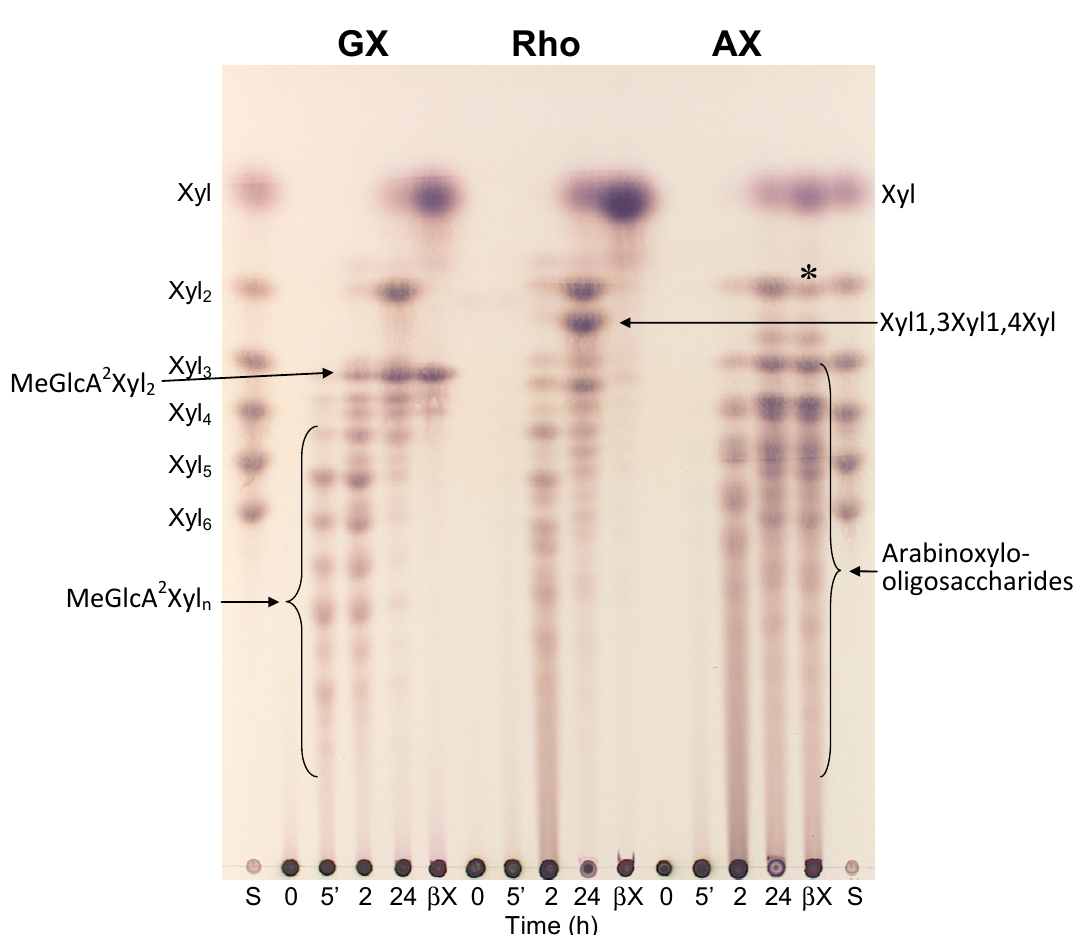
Figure 1. TLC analysis of the products generated by Tl Xyn30A xylanase from glucuronoxylan (GX), rhodymenan (Rho), and arabinoxylan (AX). After 24 h, Tl Xyn30A was heat-denatured and then the mixtures were treated with β -xylosidase for 24 h (lanes denoted by β X). Note a remarkable change in the products generated from GX and Rho upon the β -xylosidase treatment, in contrast to a resistance of the oligosaccharides generated from AX (marked by an asterisk). S—standards of linear β -1,4-xylooligosaccharides.